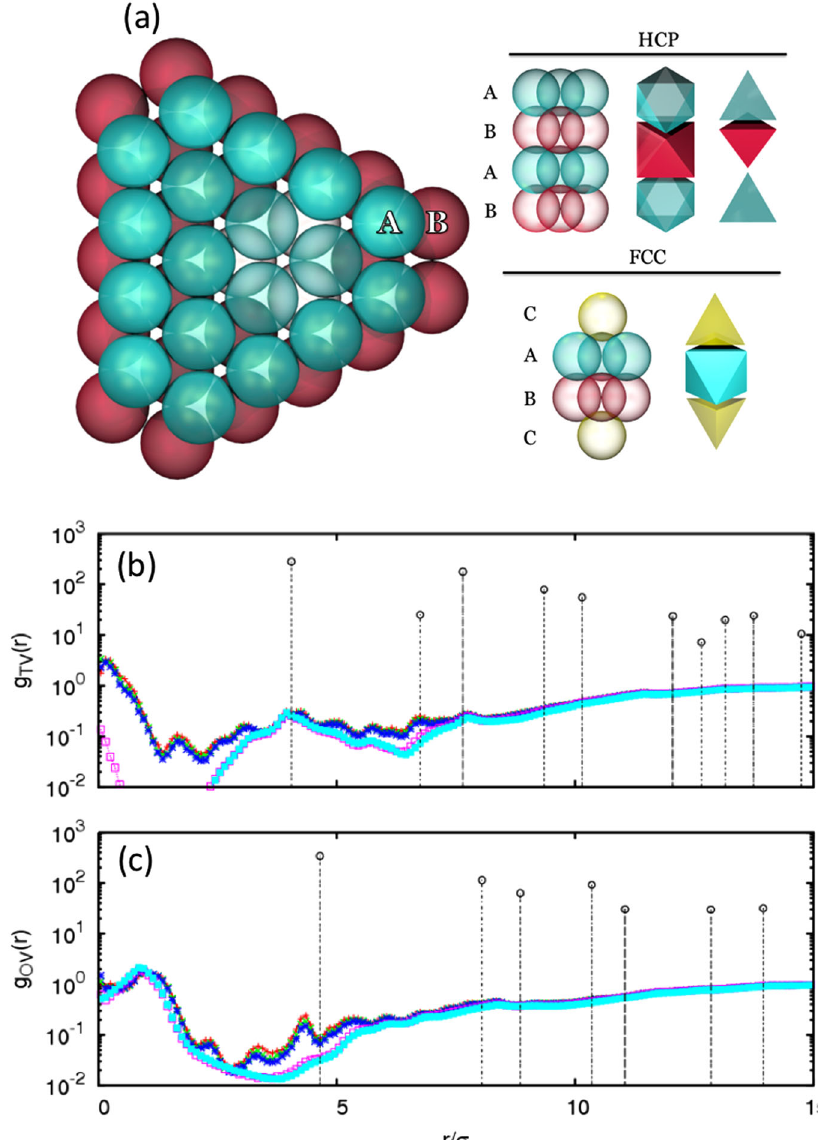
Fig. 4 a Schematic illustrations of the A-B layer, and the “ HCP- contacts ” and “ FCC-contacts ” de fi ned in text. 13 Radial distributions of polymer segments ( color symbols ) and colloids ( black circles and dashed vertical lines ) about centers of the b TV and c OV voids inside a HCP structure. ϕ p = 0.73 ( cyan ), 0.81 ( magenta ), 0.86 ( blue ), 0.91 ( green ) and 0.95 ( red